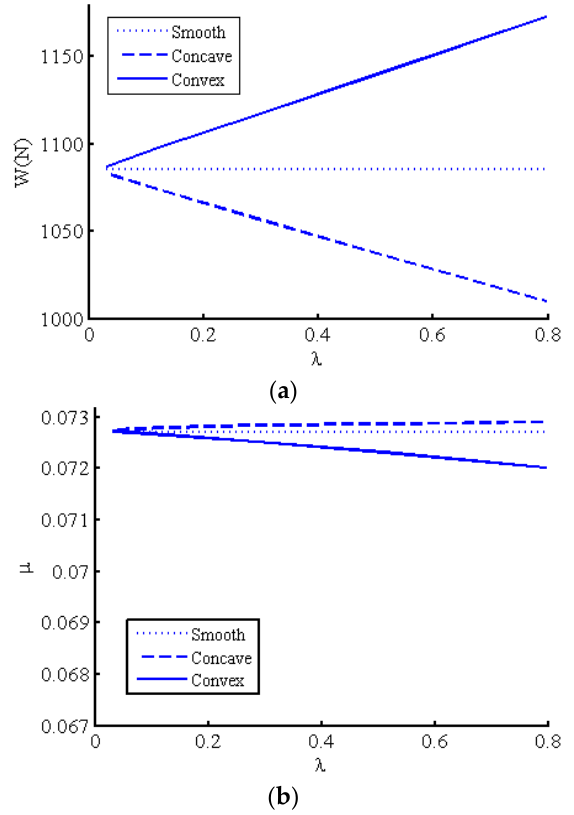
Figure 5. Effect of texture area density on ( a ) the load capacity and ( b ) the friction coefficient.